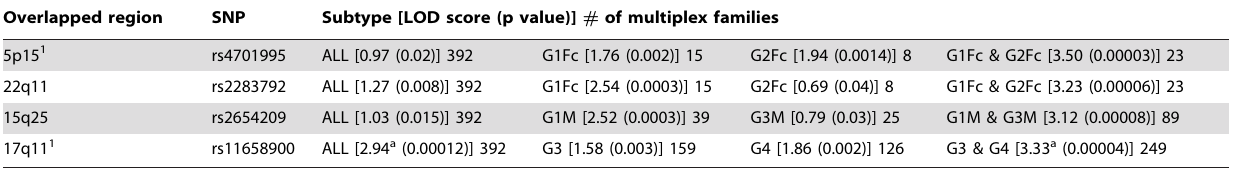
Calculated LOD scores were improved after combining the two respective subject groups. It further validates the original computed LOD scores and serves as a partial replication of our linkage results. 1 Previously reported linked region (see Table S1 in File S1 for references). a A positive LOD score of 2.94 was obtained when no stratification was applied to 392 families (i.e., ALL). The linkage results shown here for the SNP rs11658900 suggest that the subgroups G3 and G4 are the strongest contributors to the original LOD score in the unstratified cohort (ALL). Therefore, combining G3 and G4 data resulted in an improvement in the LOD score relative to ALL with fewer families (i.e.,